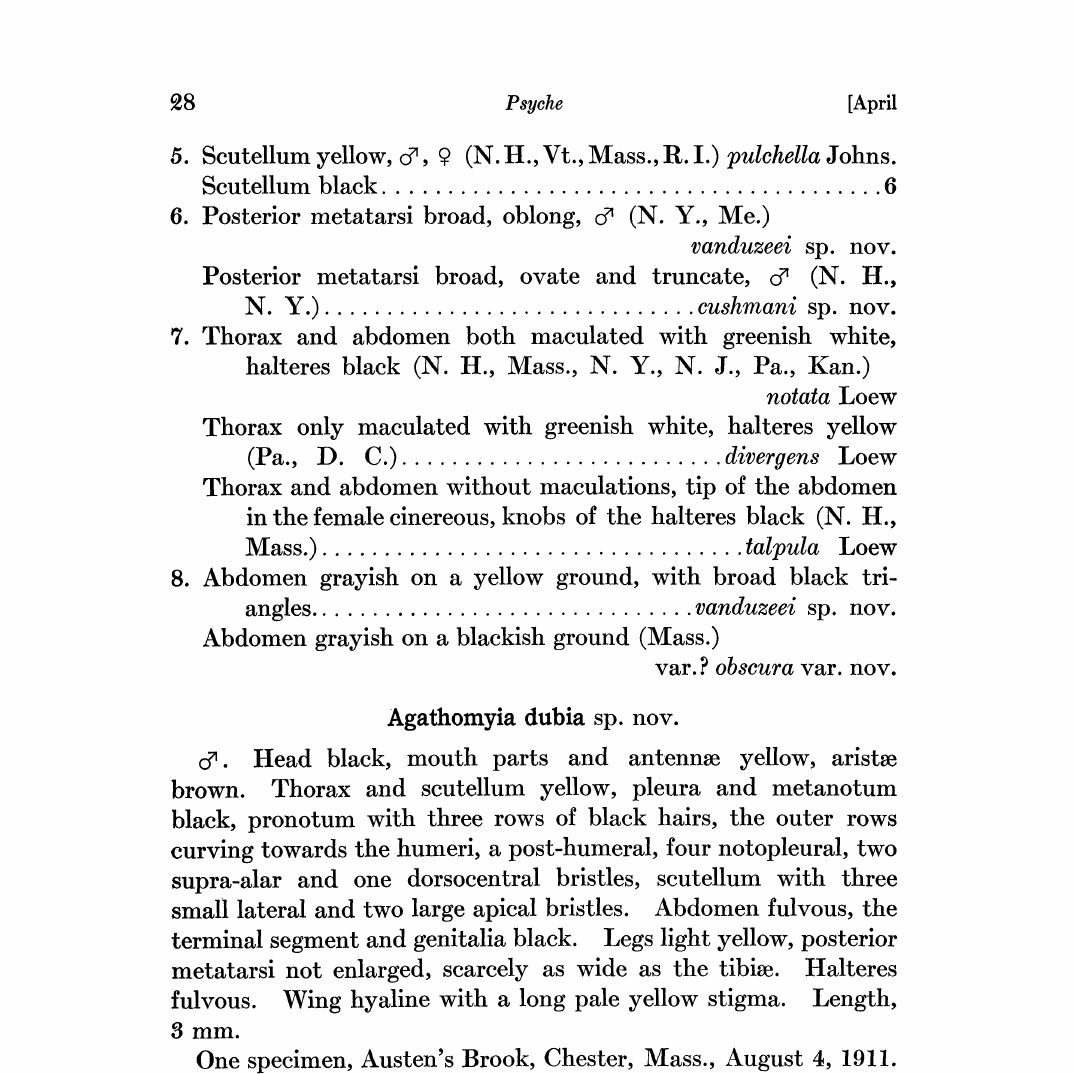
Abdomen fulvous, the terminal segment and genitalia black. Legs light yellow, posterior metatarsi not enlarged, scarcely as wide as the